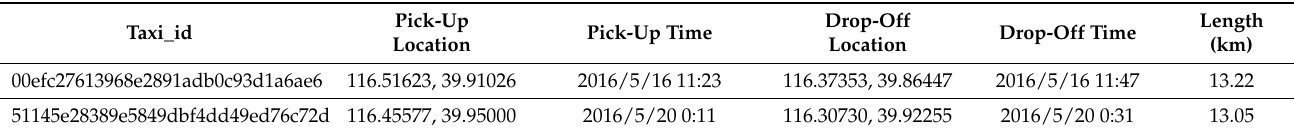
Table 1. Sample records of taxi